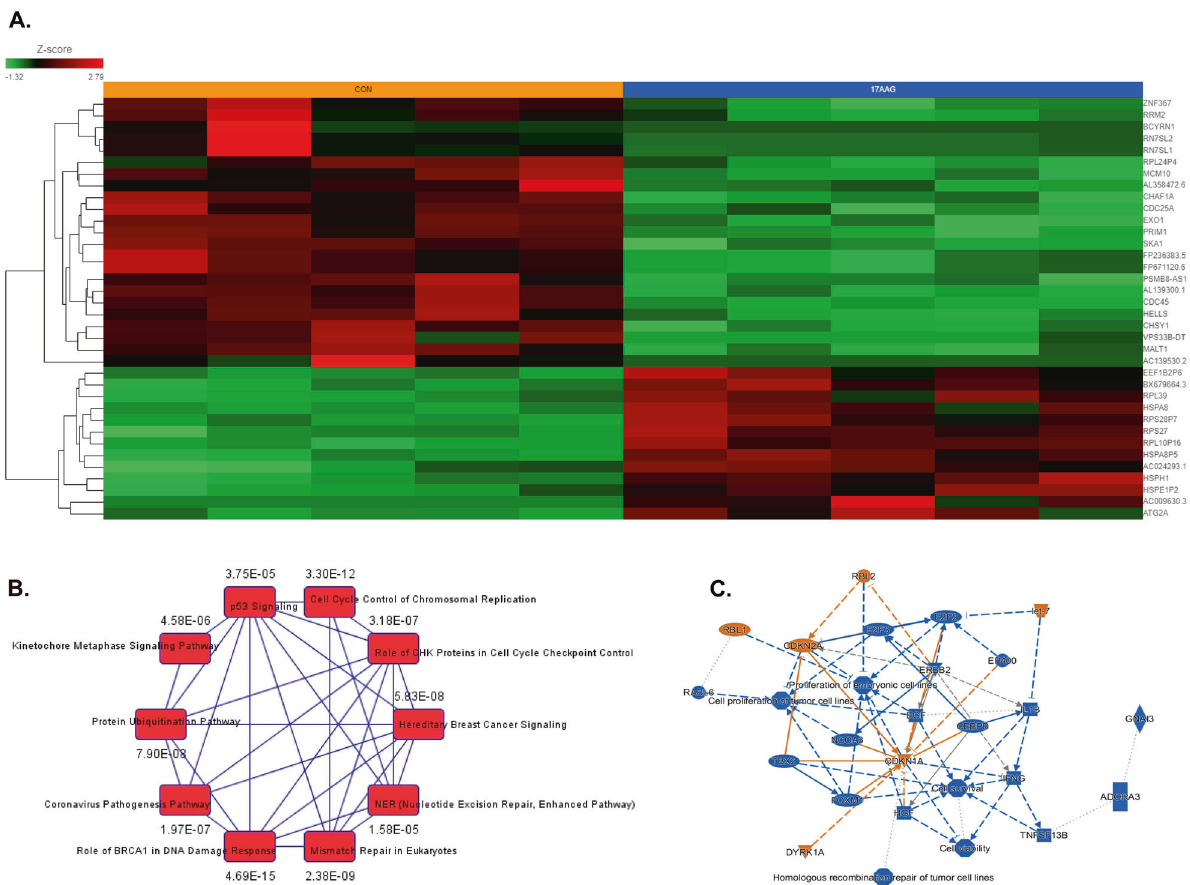
Fig. 6 Differential gene expression analysis of 17-AAG single-agent treatment. A Heatmaps generated using unsupervised hierarchical clustering (HC) analysis showing top differentially expressed genes (bulk RNAseq data) that showed signi fi cant de-regulation 24 h following Single-agent 17-AAG exposure. IPA analysis results show B canonical pathways and C graphical summary. Columns represent cell lines, and rows represent genes. Prior to Hierarchical clustering, gene expression values were z -score